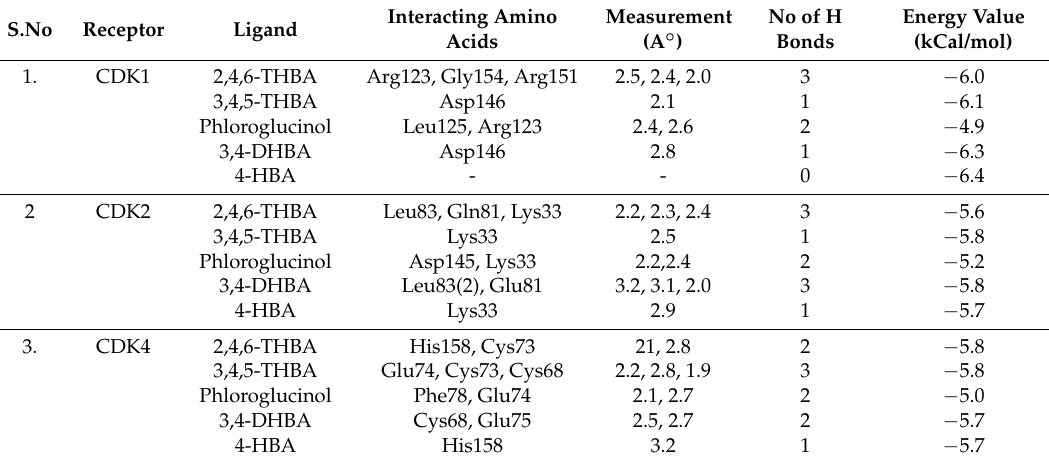
Table 1. Free energy binding values and hydrogen bond lengths for the interaction of